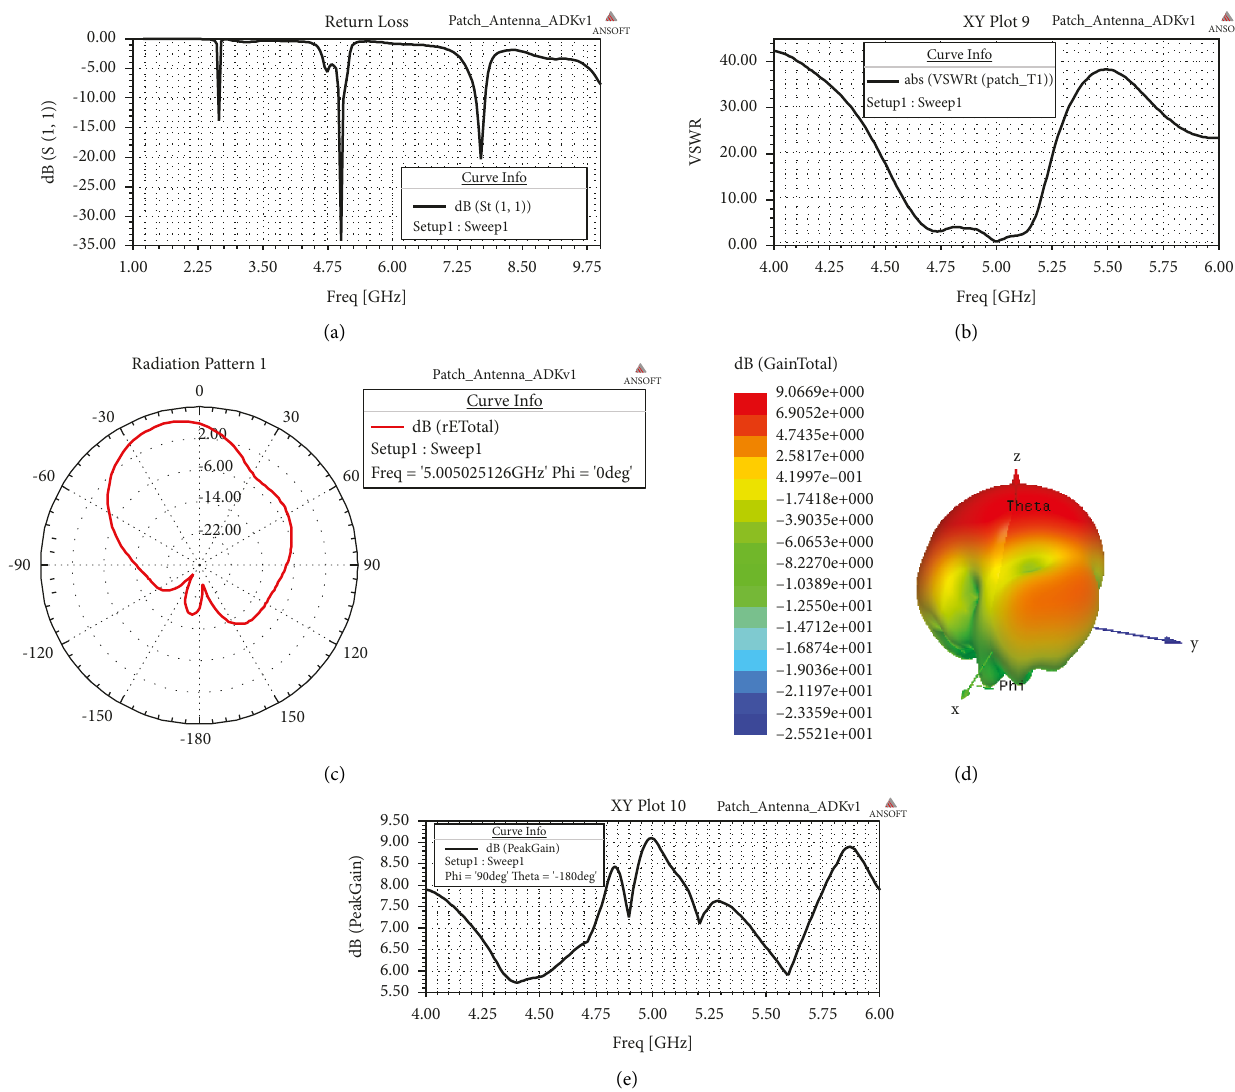
Figure 14: (a) Return loss of the metamaterial fractal antenna using HFSS simulator. (b) VSWR of the proposed antenna. (c) 2D radiation pattern of the proposed antenna at 5GHz. (d) 3D radiation pattern and gain of the proposed antenna at 5GHz. (e) The peak gain of the proposed